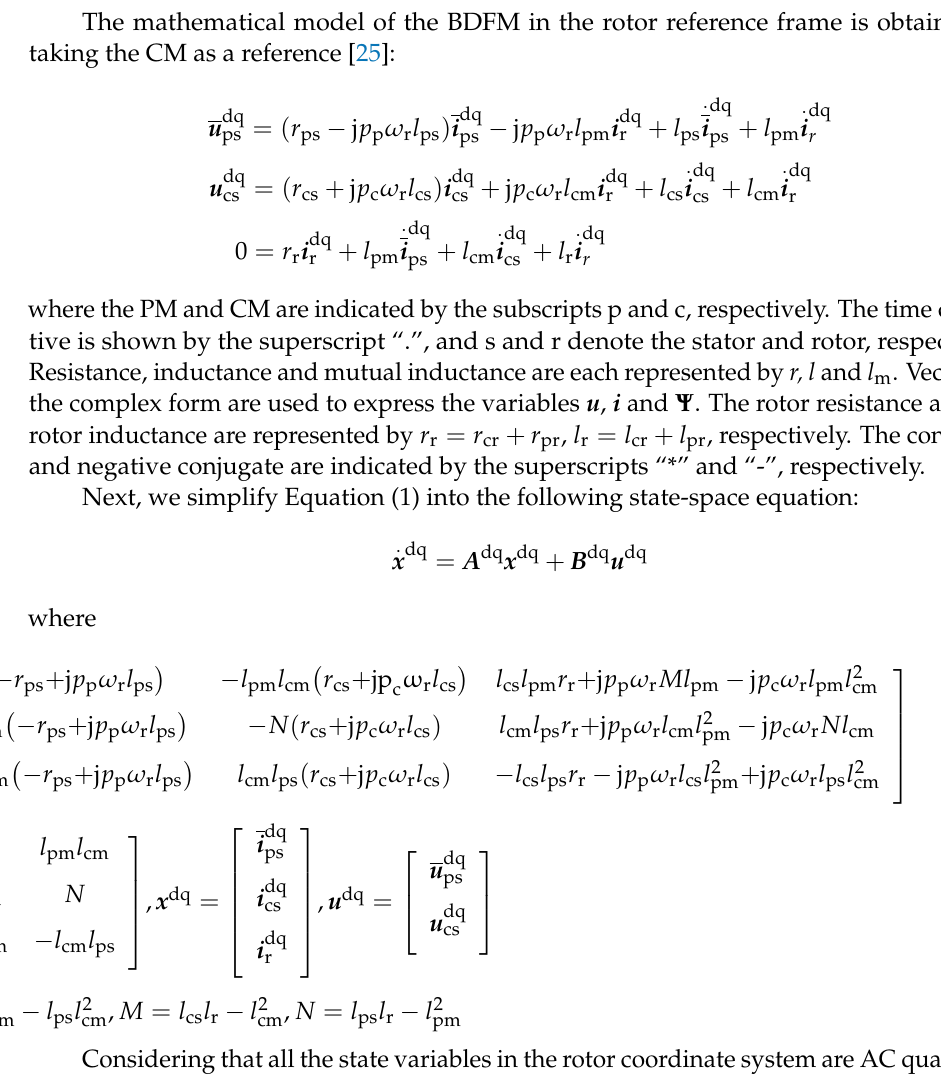
Figure 1. Structure diagram of BDFM [25].